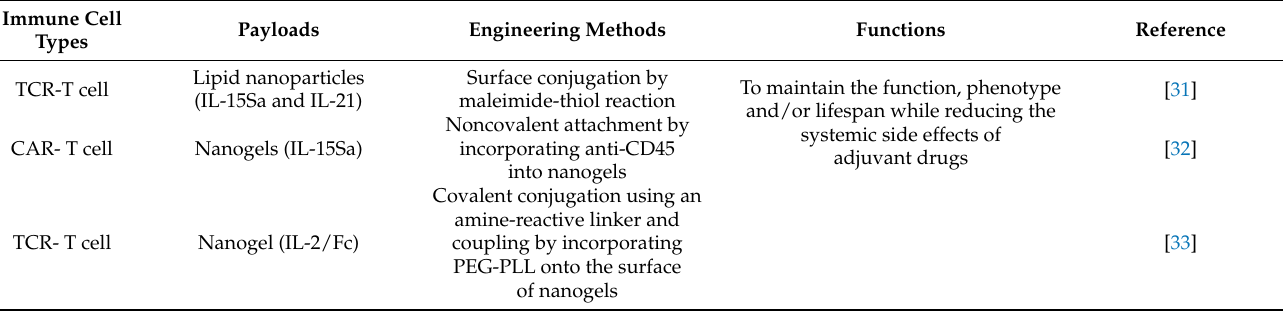
Table 2. Materials-potentiated cell engineering strategies for cancer